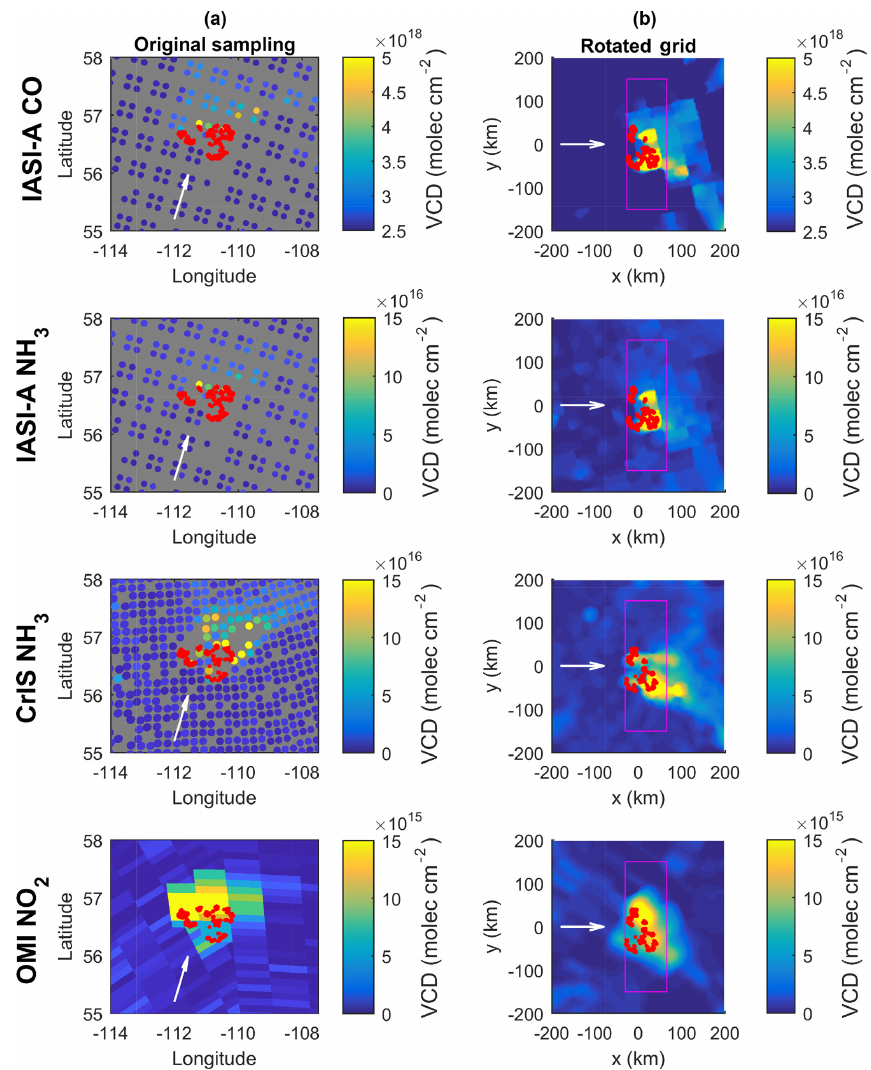
Figure 1. Example of the analysis methods for 16 May 2016, with MODIS fire hotspots indicated (red dots). (a) Satellite data are shown with original pixel sampling, with the ECMWF wind direction indicated by the white arrow. (b) Data are gridded and oriented so that + x is downwind. The pink rectangles indicate the area over which the emissions are